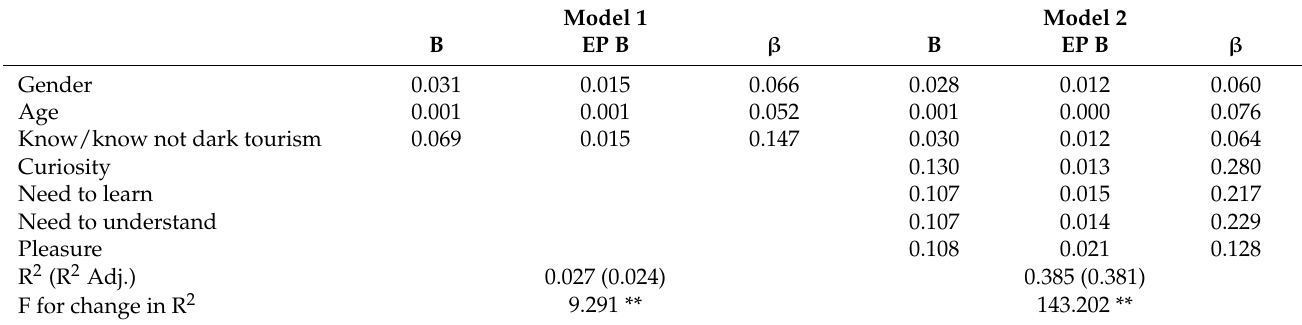
Table 8. Variables that contribute to the dark tourism practice